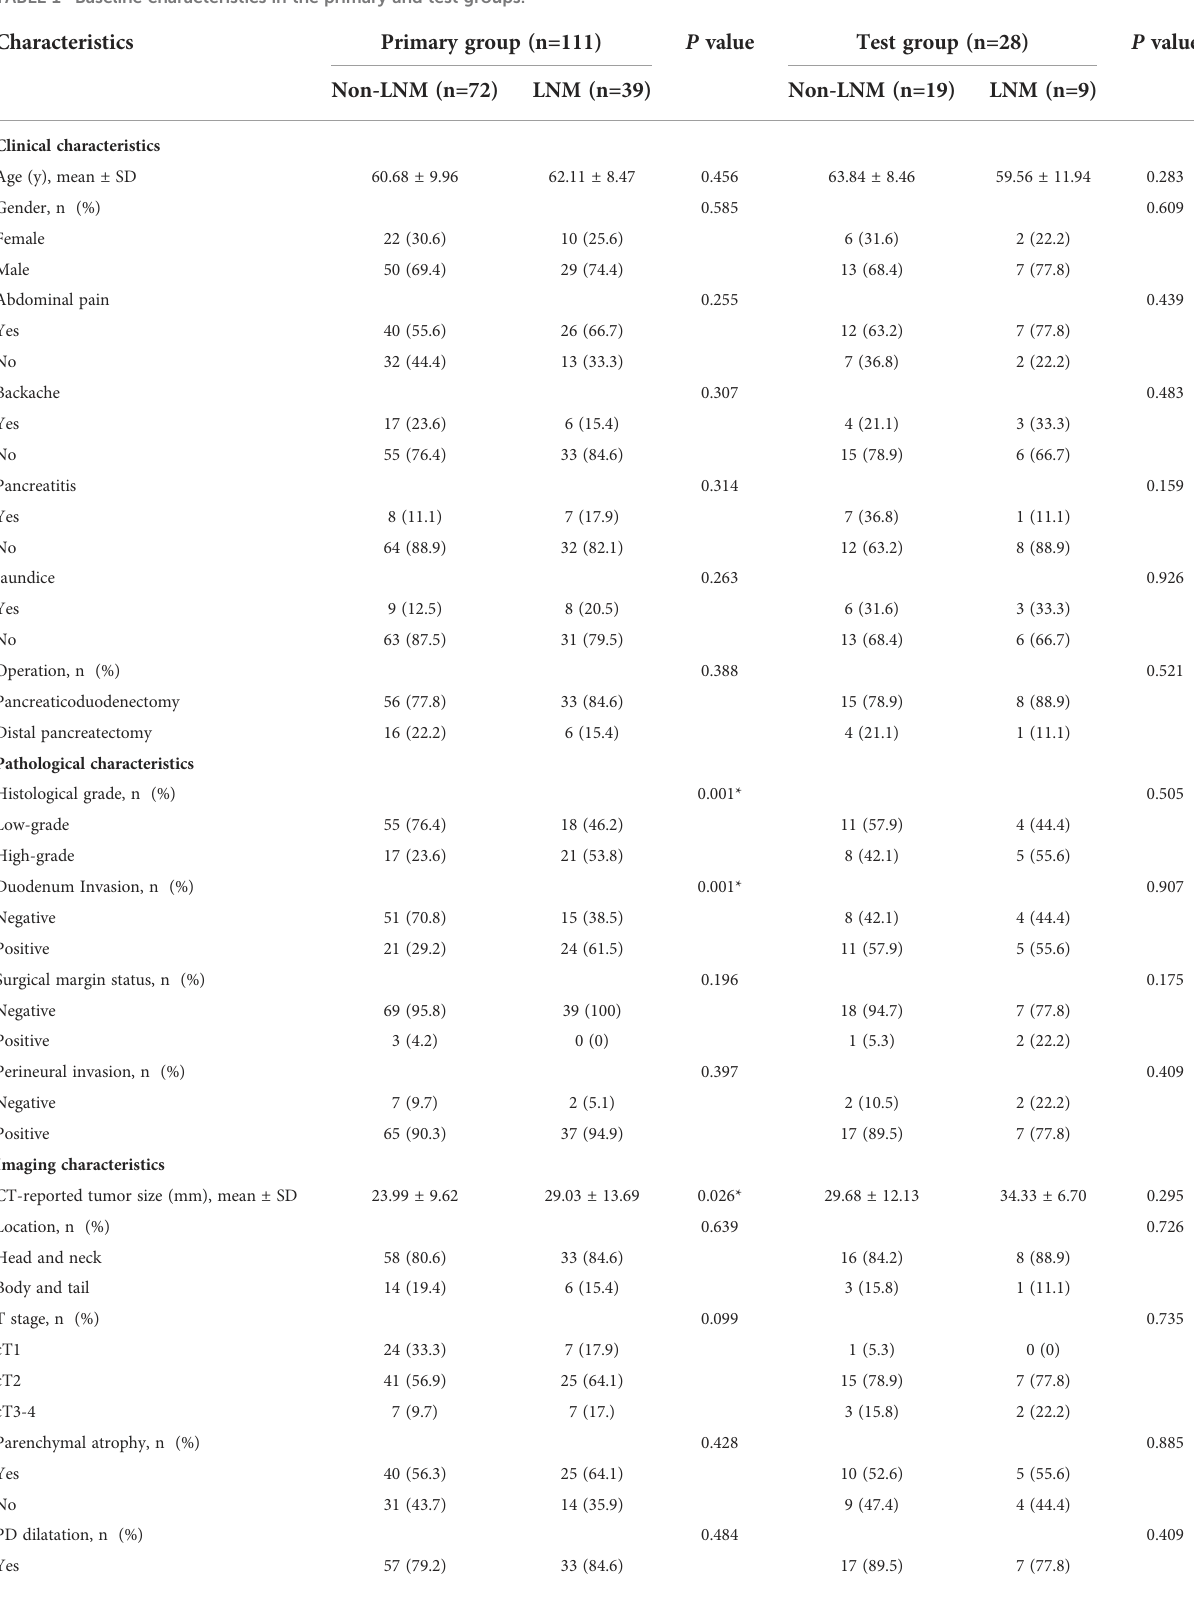
TABLE 1 Baseline characteristics in the primary and test